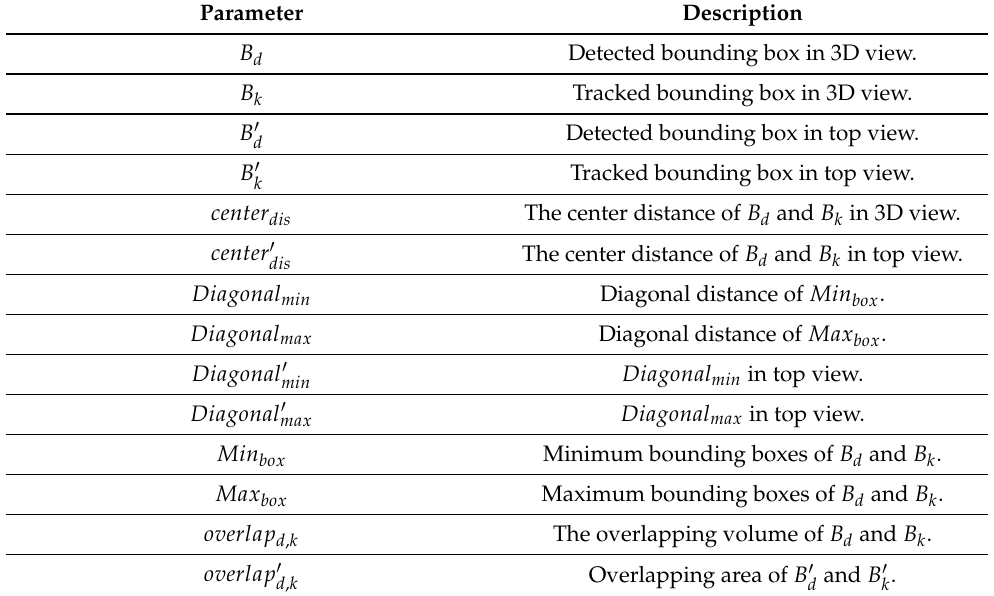
Figure 5. Views of detection boxes and tracking boxes: 3D, top, and right views. ( a ) 3D view. ( b ) Top view. ( c ) Right view. Table 2. Description of the parameters in Figures 4 and